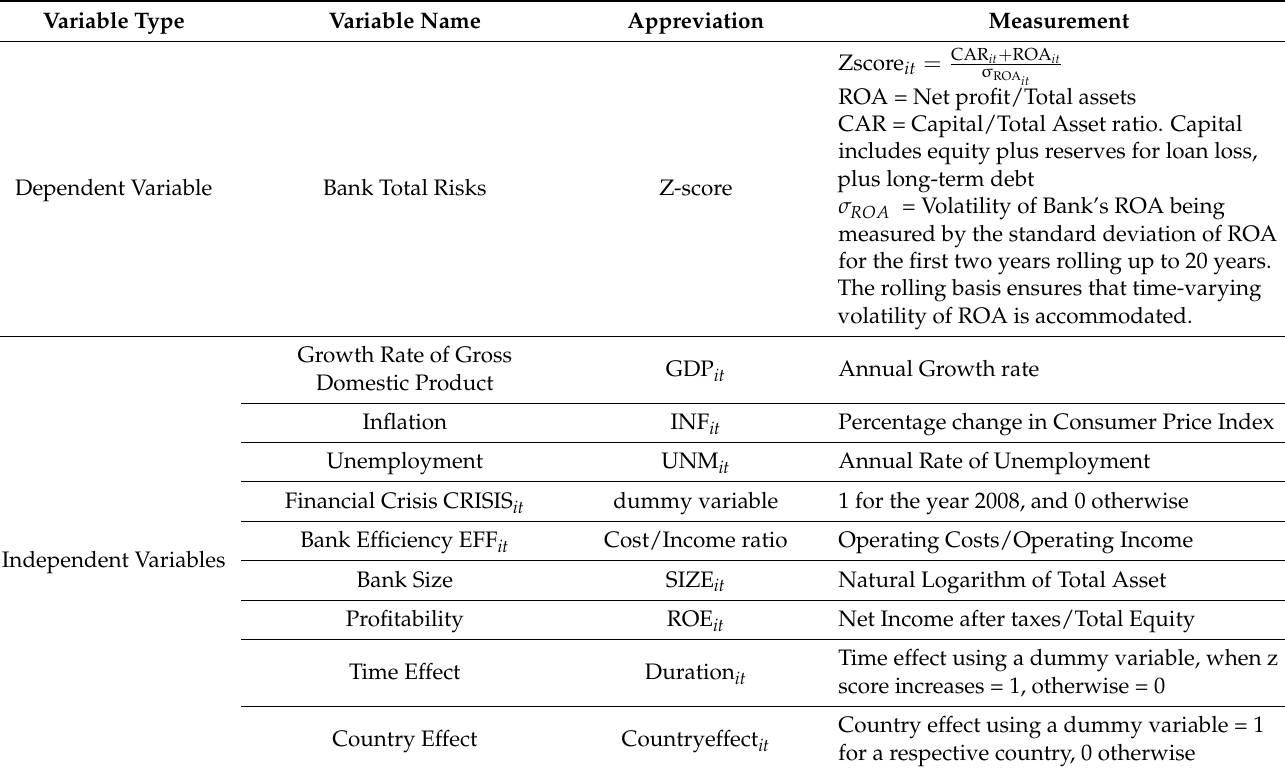
Table 1. Variable